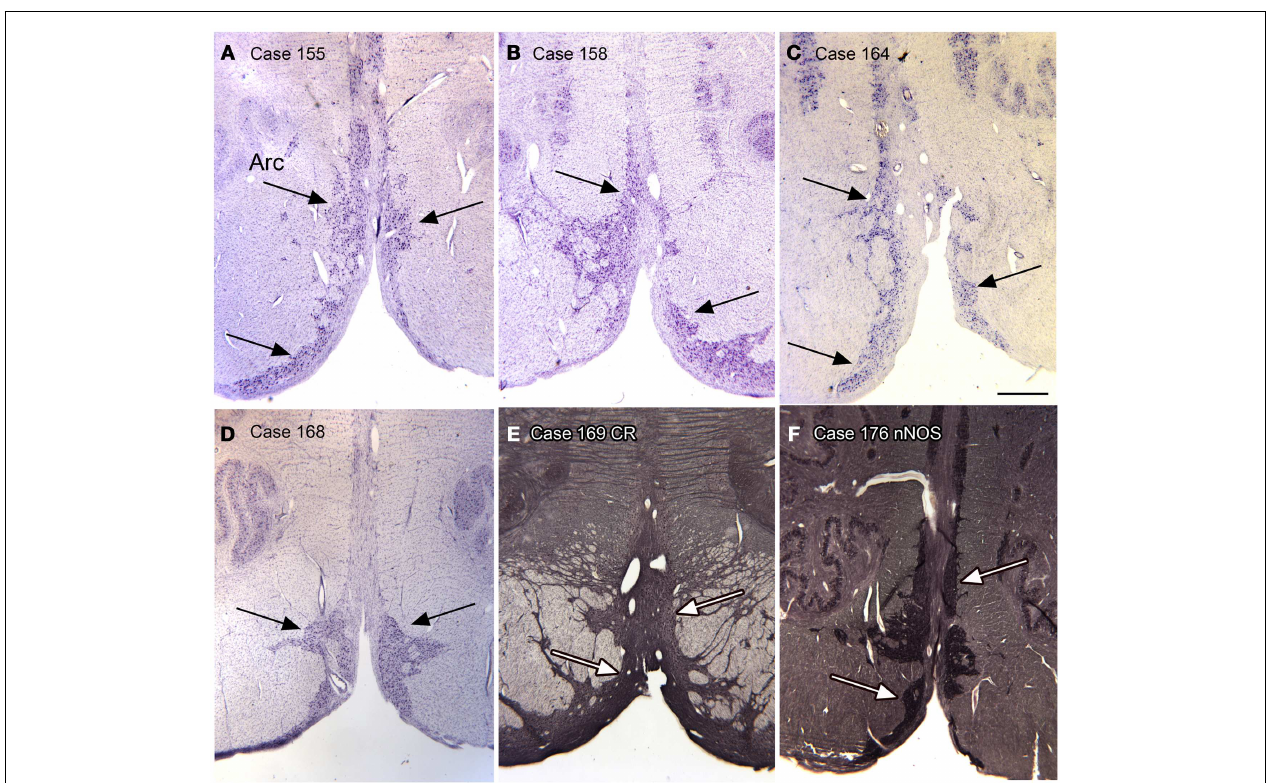
FIGURE 11 |The arcuate nucleus (Arc, arrows) in six human cases; (A–D) CV; (E) Calretinin . (F) nNOS. Scale bar